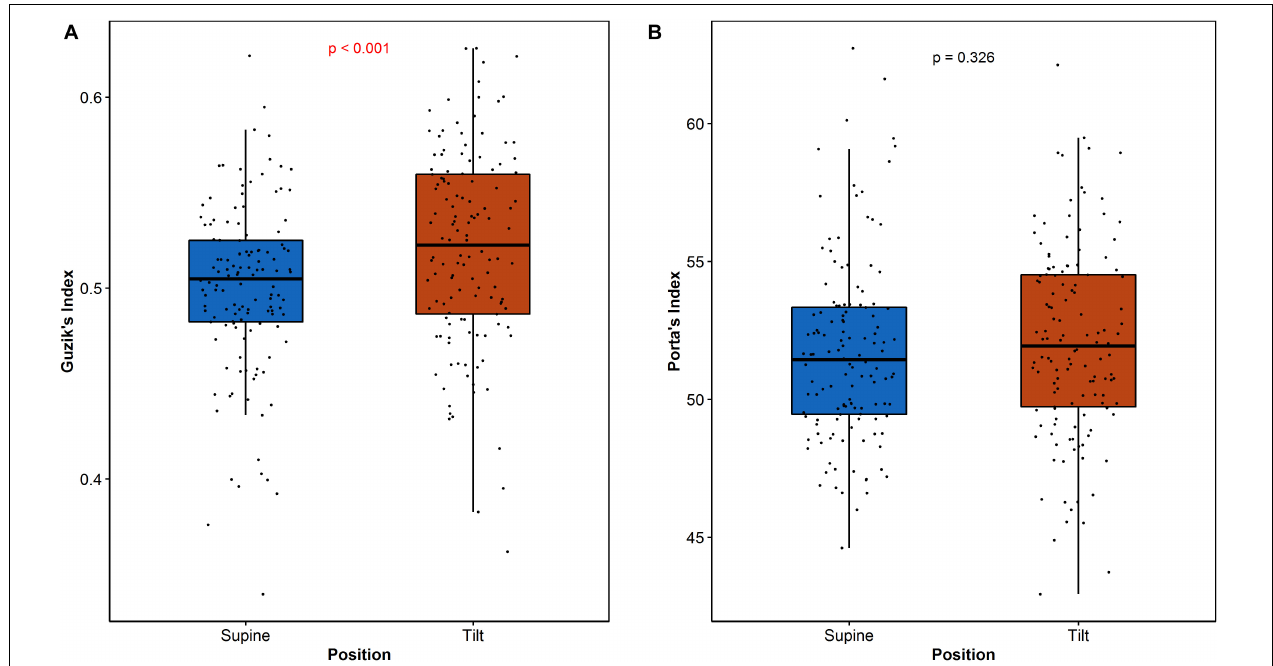
FIGURE 5 | The comparisons of indexes GI (A) and PI (B) in two HUTT phases (supine and tilt).